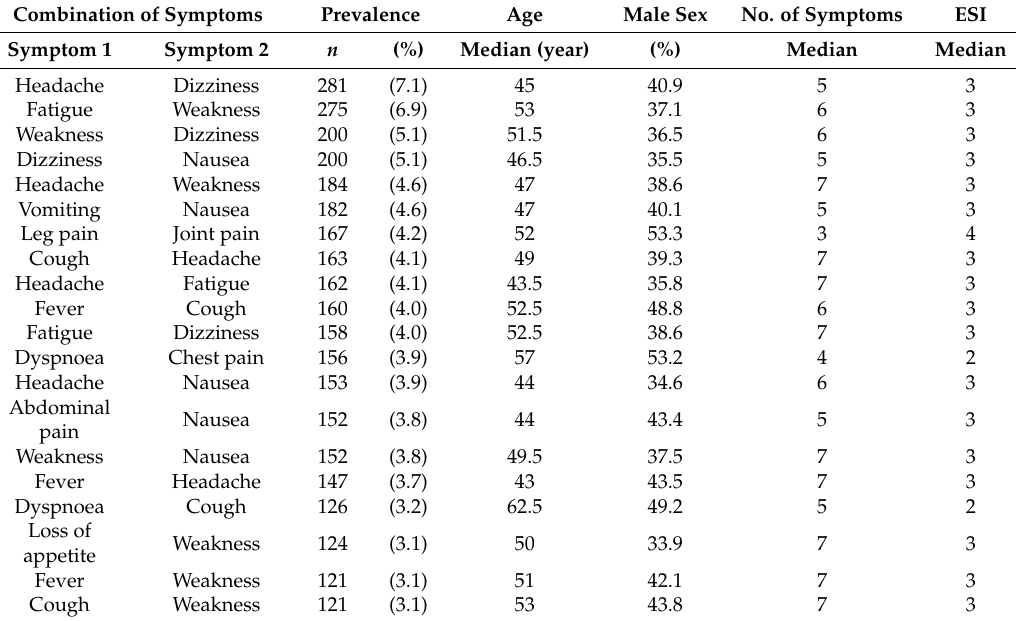
Table 1. Distribution of the 20 most frequent combinations of two symptoms.